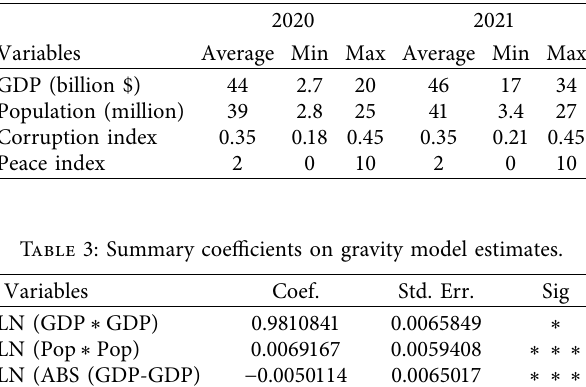
Table 2: Descriptive macro economic statistics.